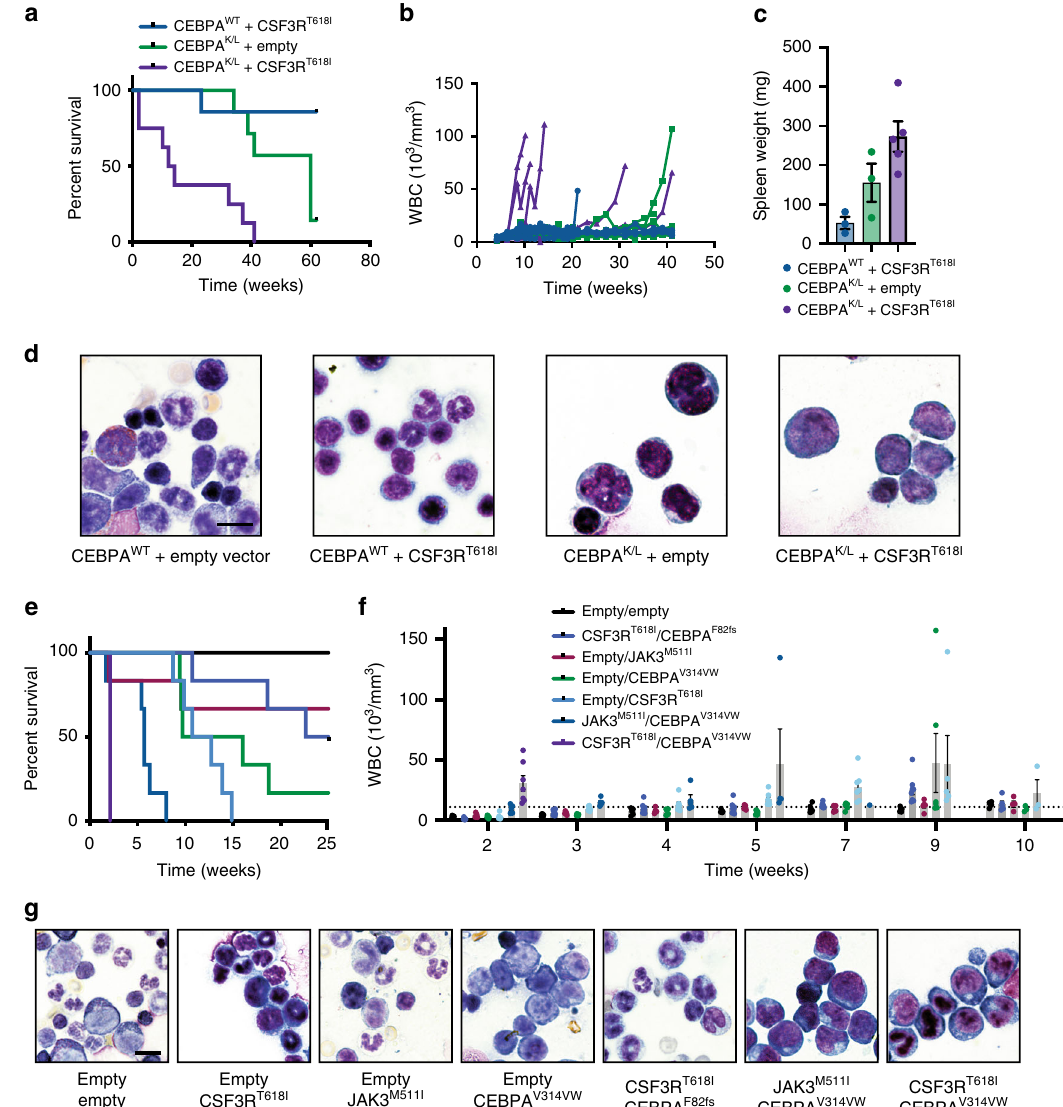
Fig. 3 JAK/STAT activation and CEBPA mutations cooperate in vivo. a Survival of mice transplanted with CEBPA wild type or CEBPA K/L fetal liver cells transduced with empty vector or CSF3R T618I ( n = 7 – 8/group). b WBC counts from mice in A. c Spleen weights from moribund mice in a ( n = 3 – 5/group). d Example bone marrow smears for mice in a (scale bar represents 10 μ m). e Survival of mice transplanted with 100,000 cells containing Empty Vector, JAK3 M511I + Empty Vector, CEBPA V314VW + Empty Vector, JAK3 M511I + CEBPA V314VW , CSF3R T618I + Empty vector, CSF3R T618I + CEBPA F82fs , or CSF3R T618I + CEBPA V314VW ( n = 5 – 6/group). f WBC counts of mice harboring mutation combinations in e ( n = 5 – 6/group at experiment start). g Example bone marrow smears from mice in e (scale bar represents 10 μ m). Values in bar graphs are represented as mean with error bars representing SEM. Source data are provided as a Source Data fi